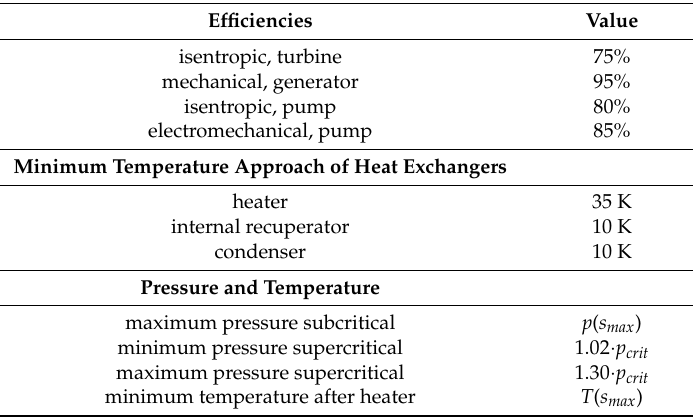
Table 1. Boundary conditions for process